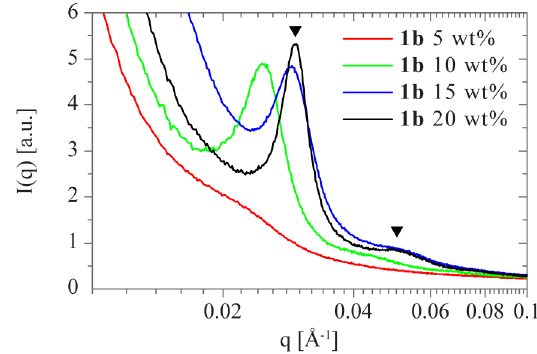
Figure 7. Small-angle X-ray scattering profiles of 1b at 5 (red), 10 (green), 15 (blue) and 20 wt % (black) samples measured in PBS at room temperature. Solid triangles correspond to the allowed reflections ( q = q *(1, √ 3)) for hexagonal